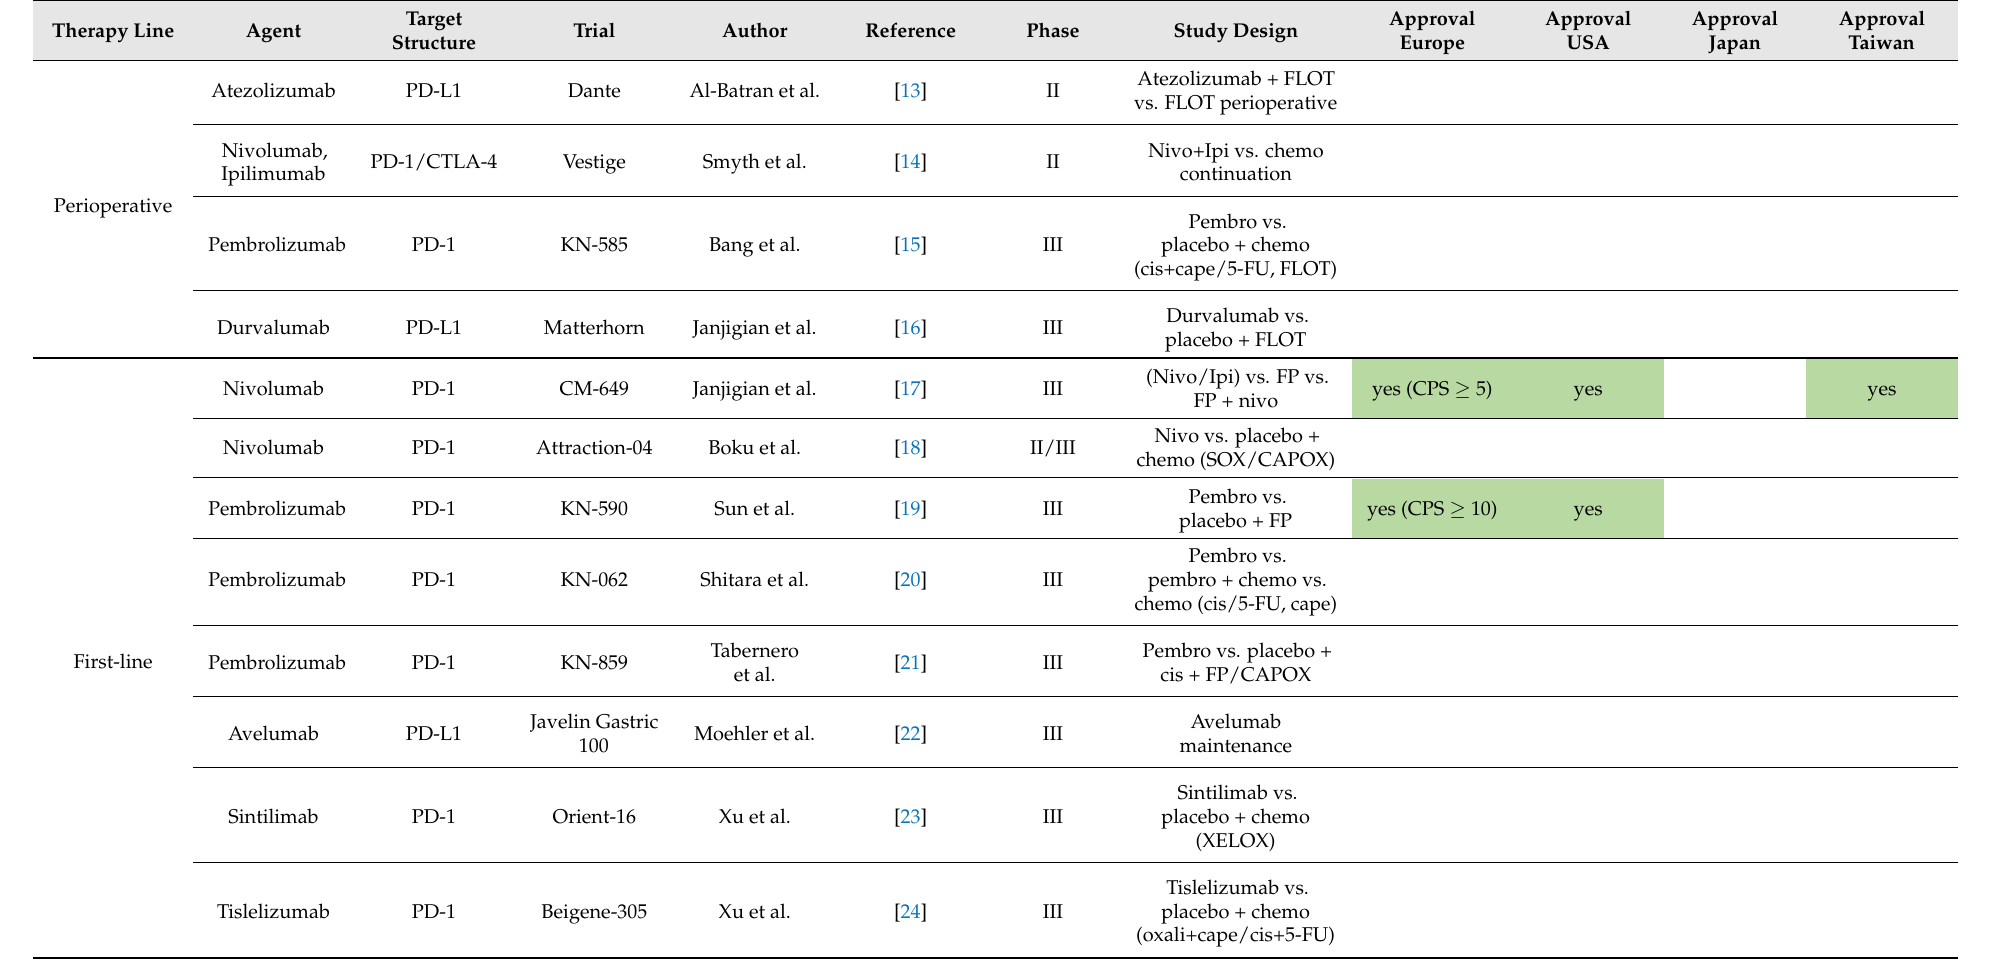
Table 1. Overview of clinical trials of immune checkpoint inhibitors in esophagogastric